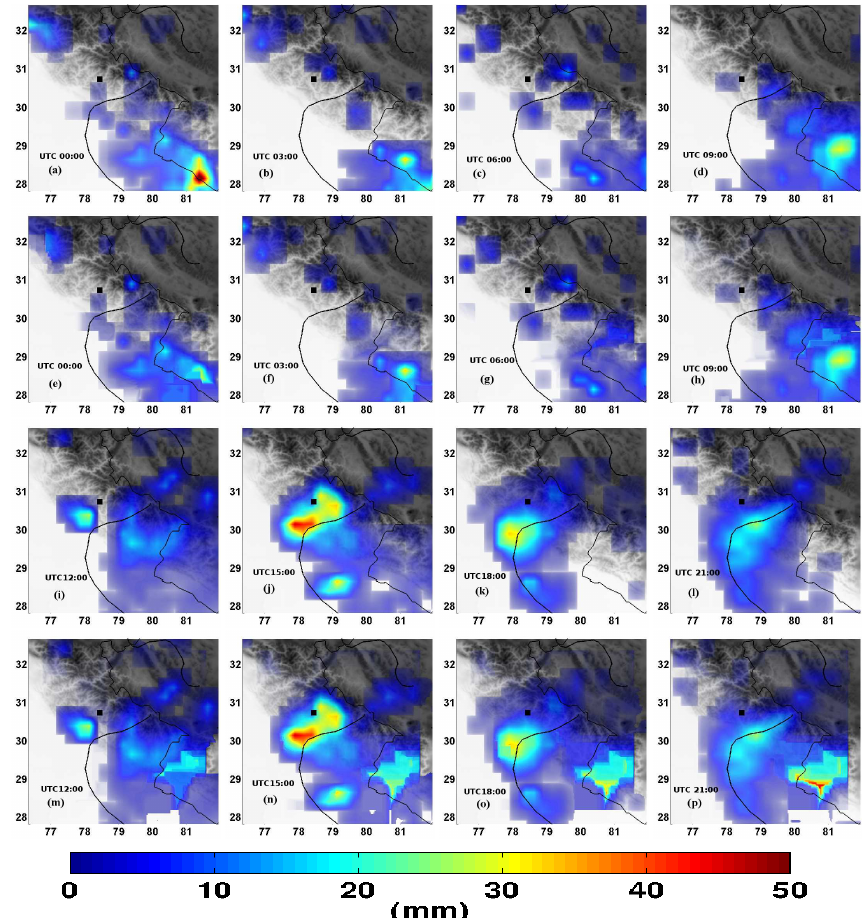
Figure 10. Comparison of TRMM 3B42v7 3h rainfall ( a – d and i – l ) and WRF simulation using the best nested configuration ( e – h and m – p ) for 3 August 2012 inside domain 3. The topography of the location is shown in grayscale in the